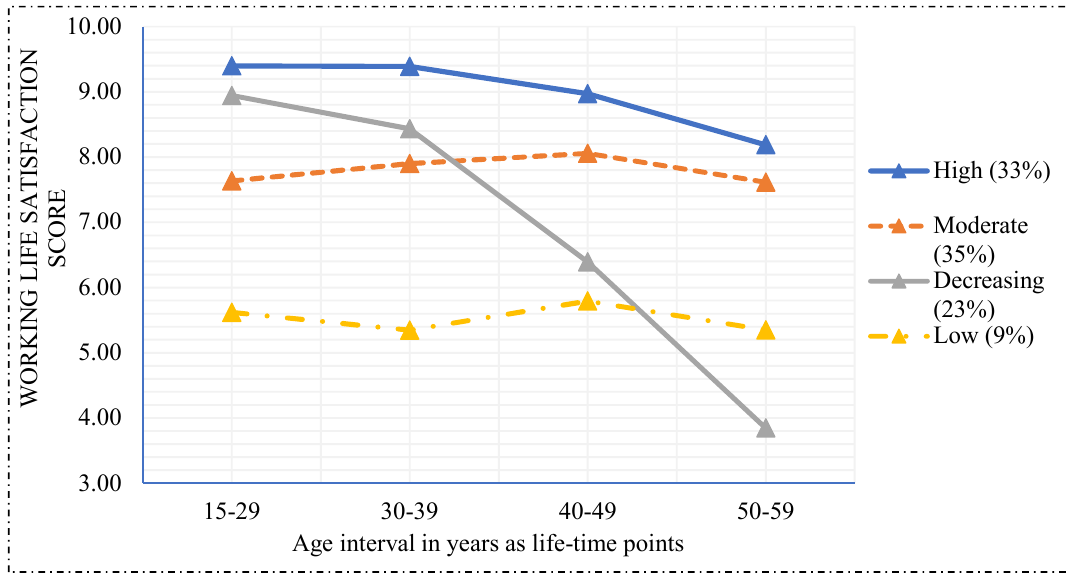
Figure 1. Trajectories of work life satisfaction among the respondents.